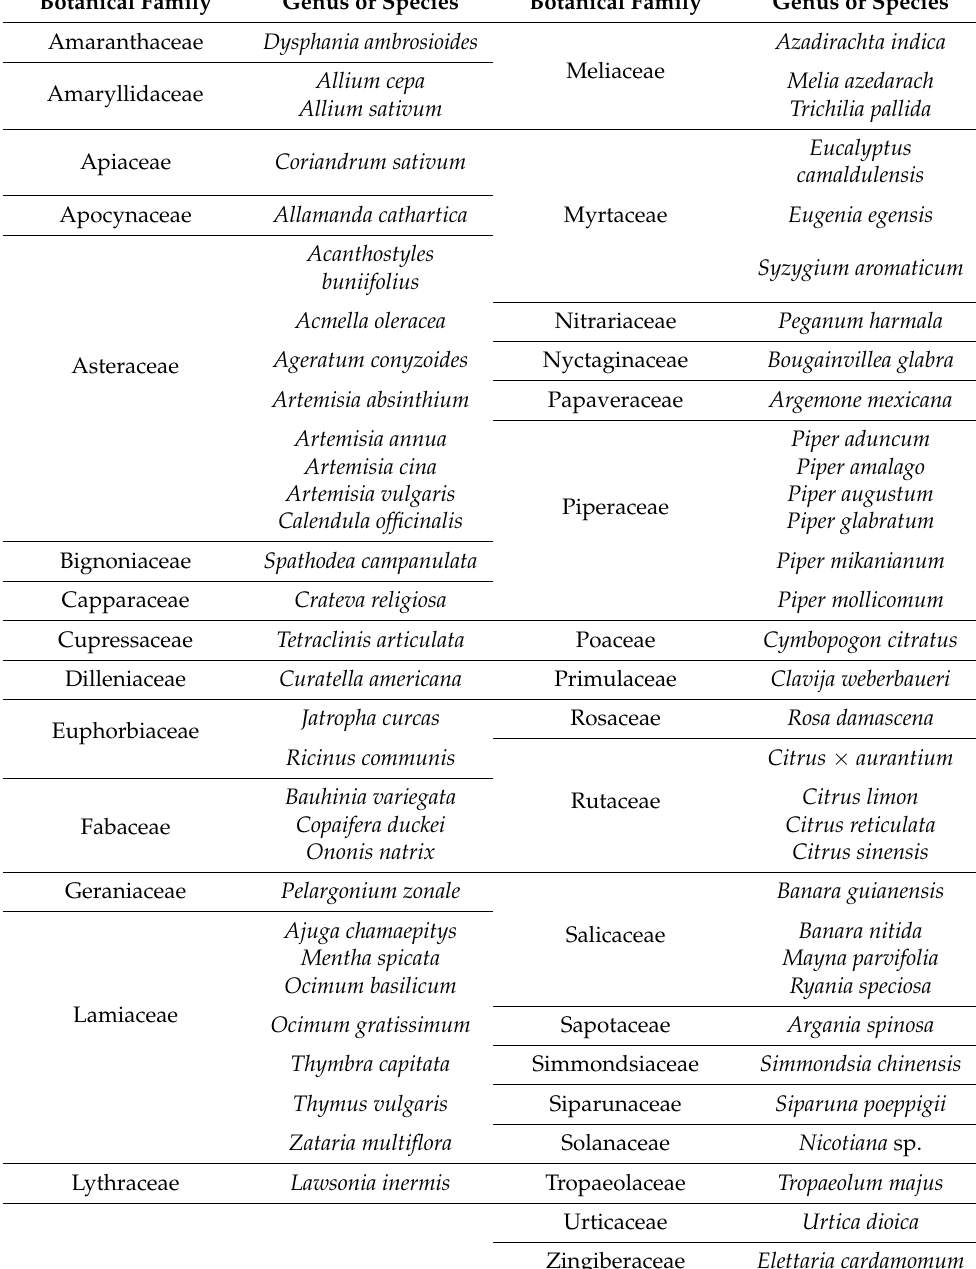
Table 5. Plant species reported in KB as used against the tomato pest Tuta absoluta . Botanical